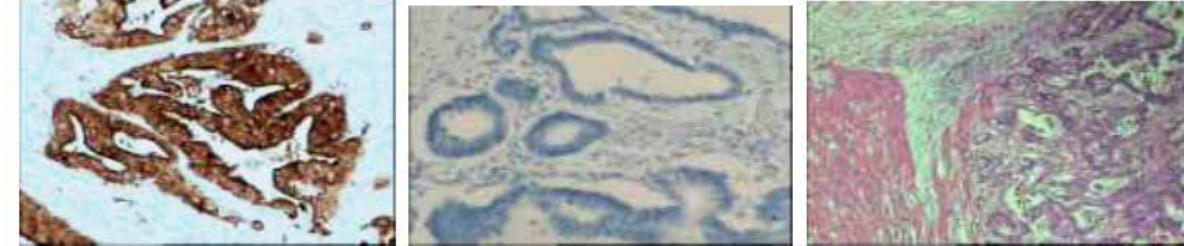
Figure 1: A. Hepcidin Positive (×100); B. Negative stain control (×100) C H&E